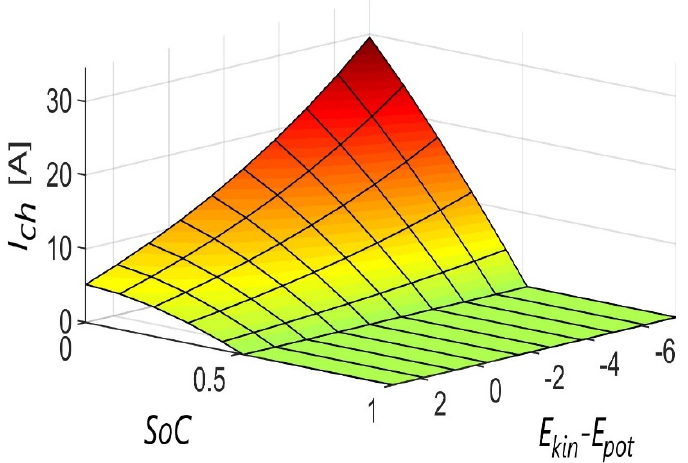
Figure 16. Supercapacitor grid charging current surface for the minimum energy algorithm.